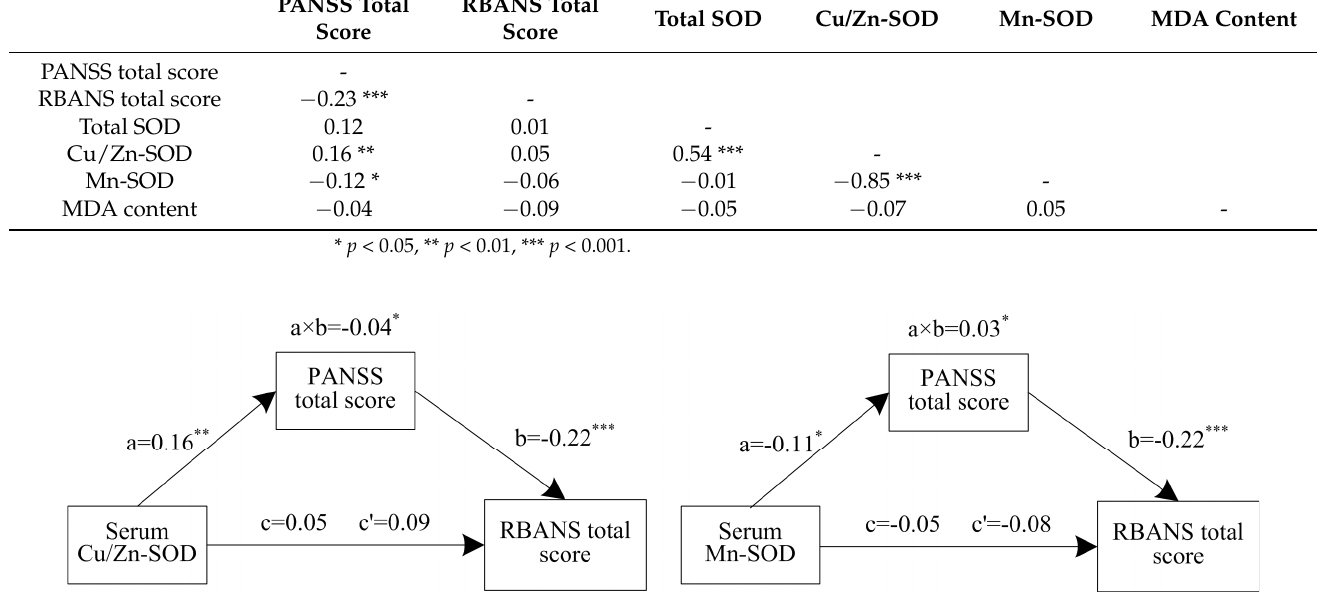
Figure 1. Mediation models: The relationship between serum Cu/Zn–SOD/ Mn–SOD and cognition through psychotic symptoms. a × b: the indirect effects of oxidative stress on cognition; c = the total effects of oxidative stress on cognition; c’ = the direct effects of oxidative stress on cognition; a = the effects of oxidative stress on psychotic symptoms; b = the effects of psychotic symptoms on cognition. * p < 0.05, ** p < 0.01, *** p <